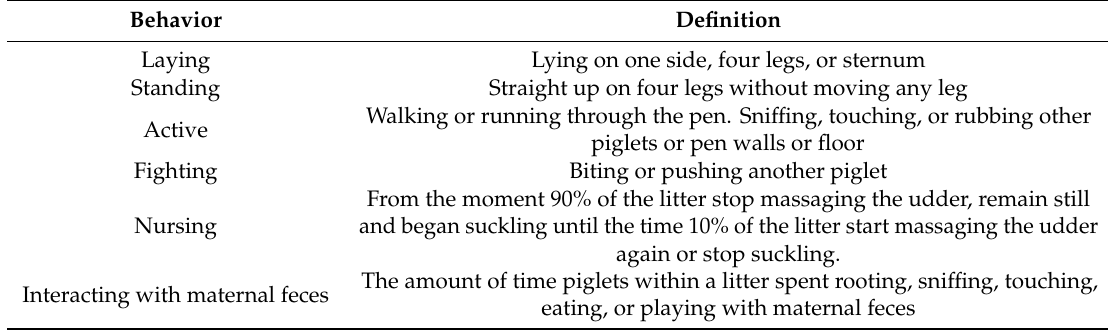
Table 2. Behavior